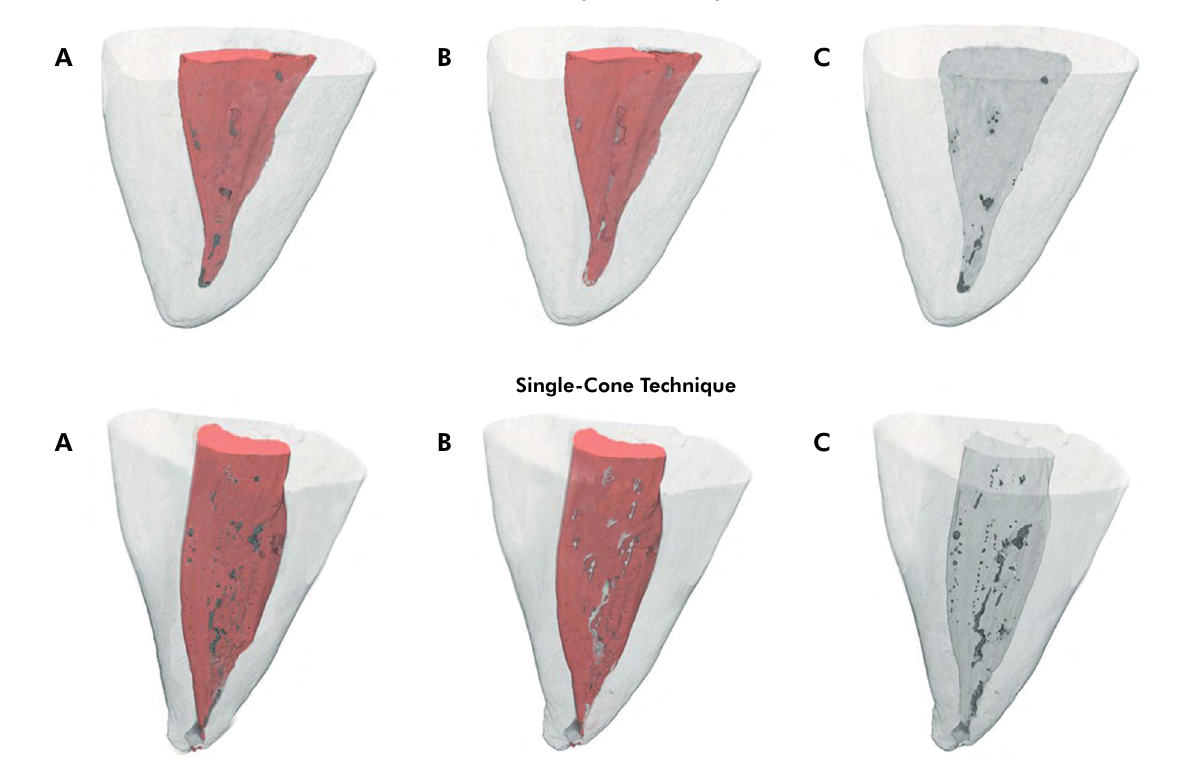
Figure 2. Three-dimensional reconstructions of two flattened distal canals of mandibular molars filled with Bio-C Sealer using thermoplastic or single-cone techniques. Filling material is represented in pink and voids in black. (a) Filling material and voids; (b) filling material; (c)